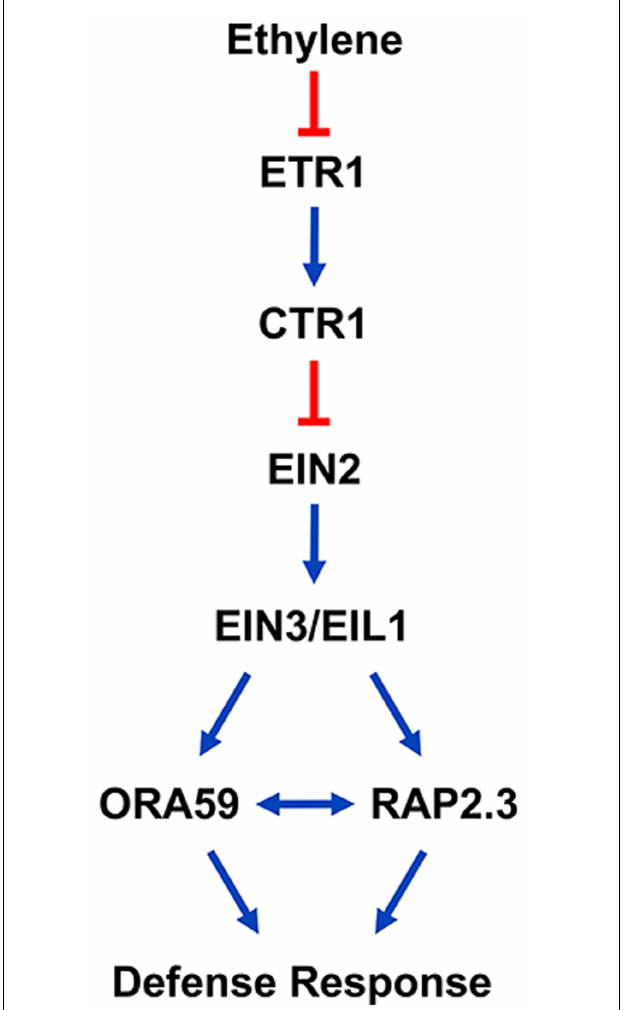
FIGURE 6 | A model proposing that ORA59 and RAP2.3 interact downstream of EIN2 and EIN3/EIL1 in the ethylene signaling pathway to regulate defense responses. Arrows and bars indicate positive and negative regulation, respectively, and double arrow indicates the interaction between ORA59 and